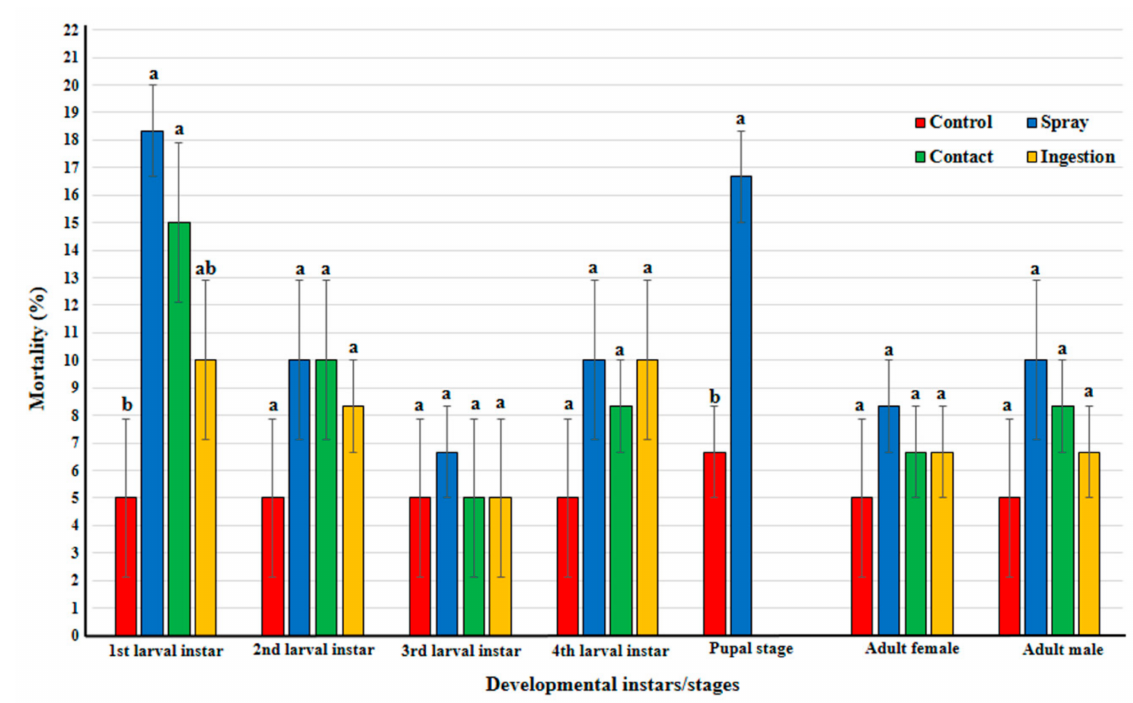
Figure 2. Percent mortality of larva, pupa, and adults of Coccinella undecimpunctata treated with three different applications with Beauveria bassiana. Different letters above bars indicate significantly different means according to Duncan test ( α = 5%) except of pupal stage with t -test ( α =